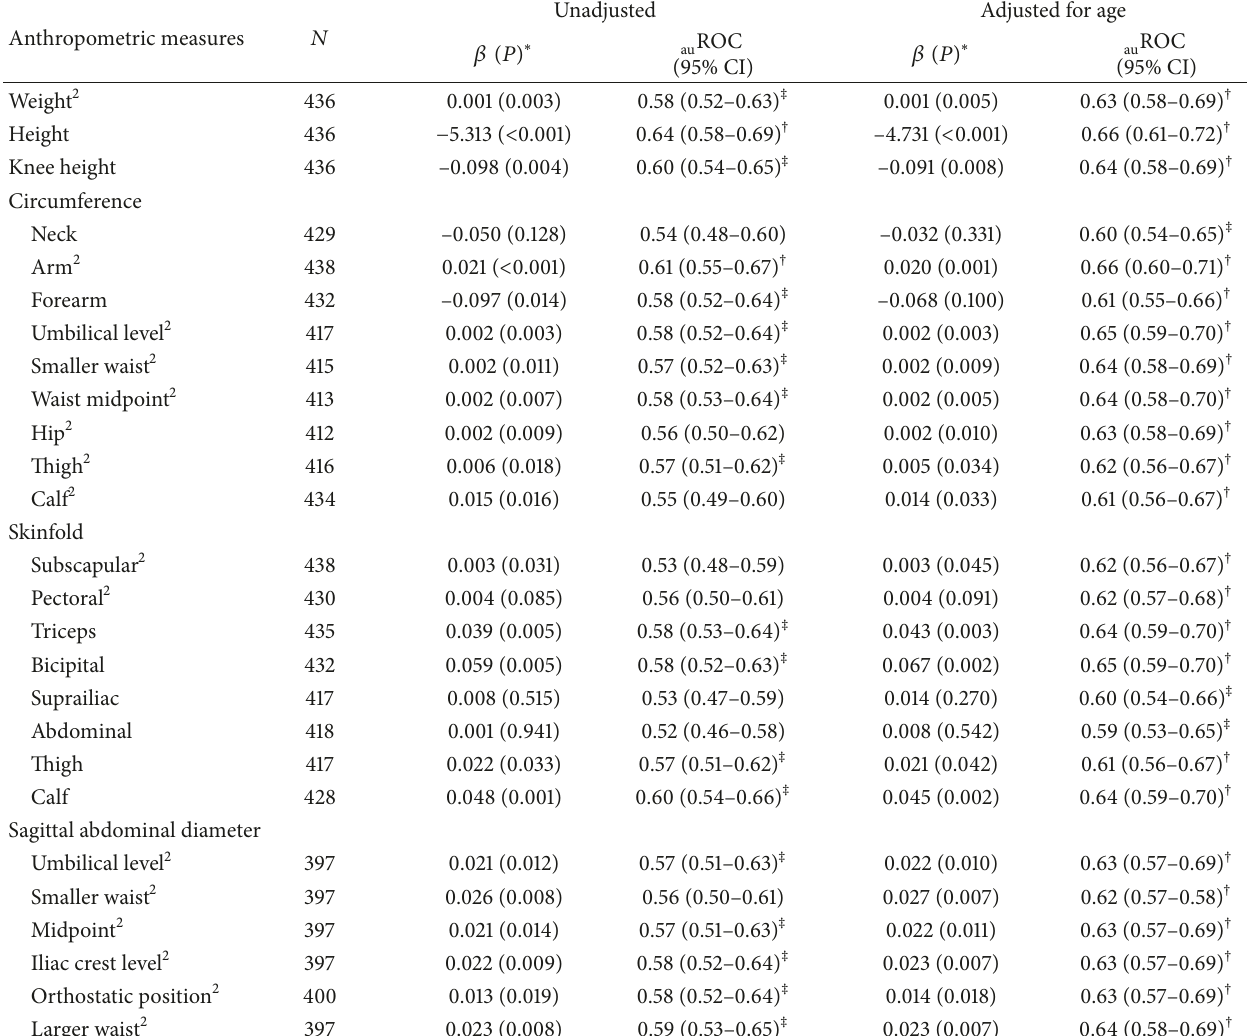
ROC results for the learning au